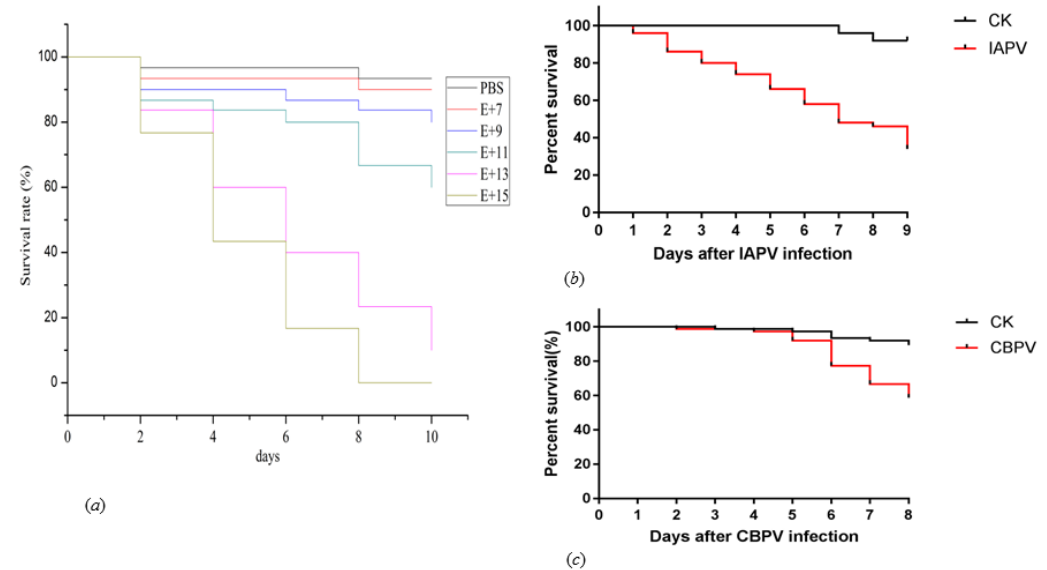
Figure 3. Effects of infectious clones of IAPV and CBPV on honey bees survival rates. The survival rates of honey bees in the control groups and those injected with five different concentrations of the infectious clone of IAPV: 1 × 10 7 , 10 9 , 10 11 , 10 13 , and 10 15 genomic copies ( a ). The survival rates of honey bees in the control groups and those injected with 10 12 genomic copies of the infectious clones of IAPV ( b ) and CBPV ( c ). CK: blank control.